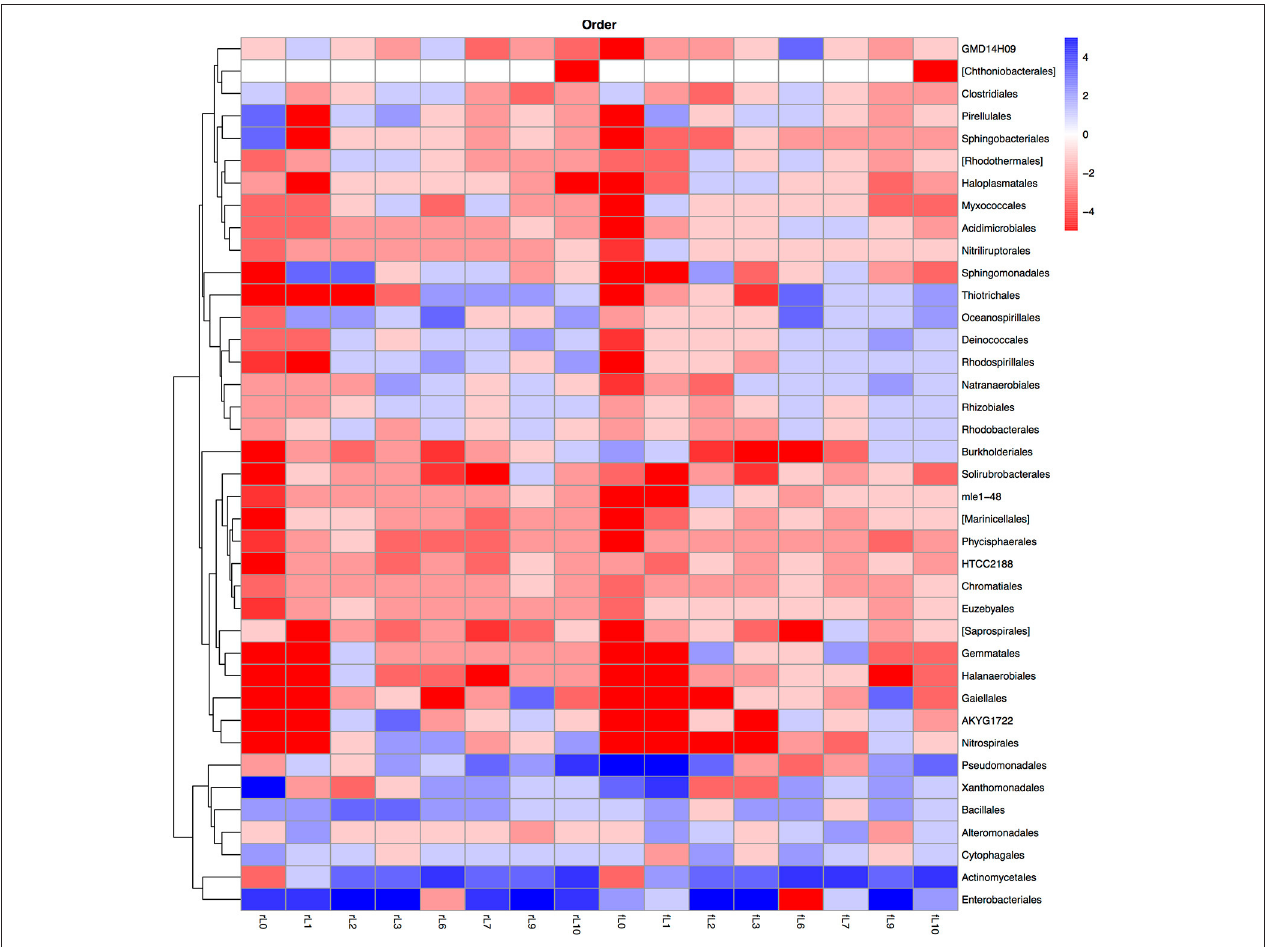
FIGURE 9 | Heatmap of the ratio between the relative abundance of the different bacterial orders in the unamended soil vs. the soil amended with maize plantlets or its neutral detergent fiber (NDF). Legends to the figure can be found in Figure 5